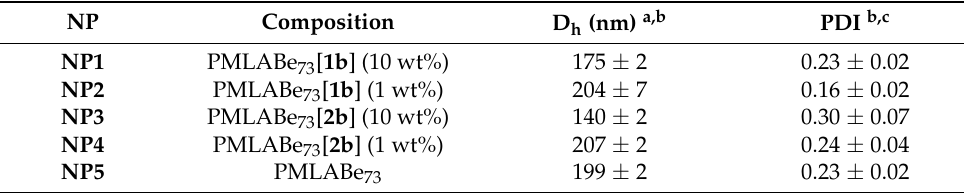
Table 2. Composition, hydrodynamic diameter (D h ) and polydispersity (PDI) of porphyrin-loaded and empty NPs after concentration step.